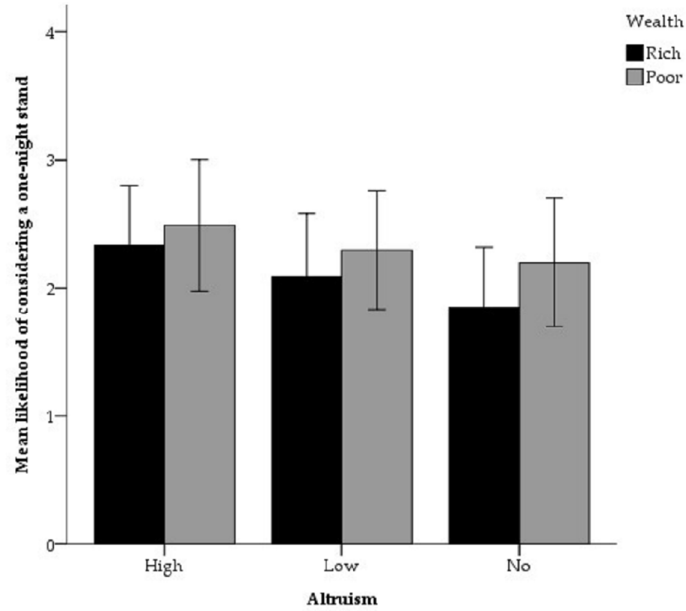
Figure 2. The likelihood that participants in the high-cost, low-cost, and no altruism conditions would consider having a one-night stand with the actor when he was described as rich compared to when he was described as poor (error bars represent 95% confidence intervals).